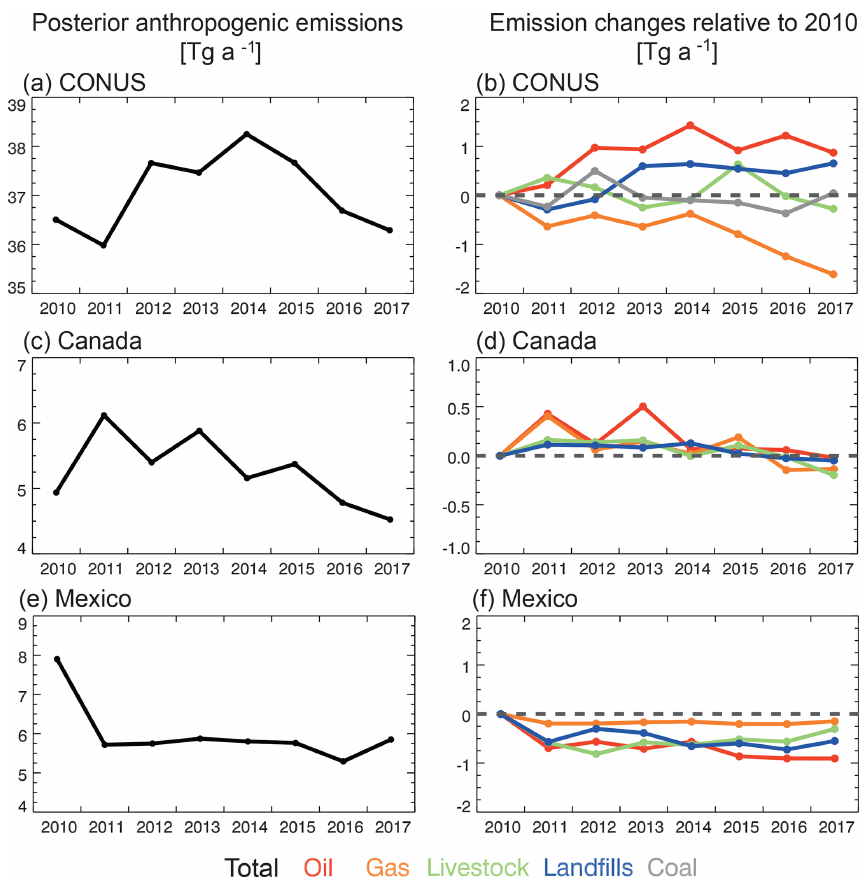
Figure 9. The 2010–2017 trends in anthropogenic methane emissions in CONUS, Canada, and Mexico as inferred from the base inversion. The left panels show the total national anthropogenic methane emissions, and the right panels show changes relative to 2010 for major